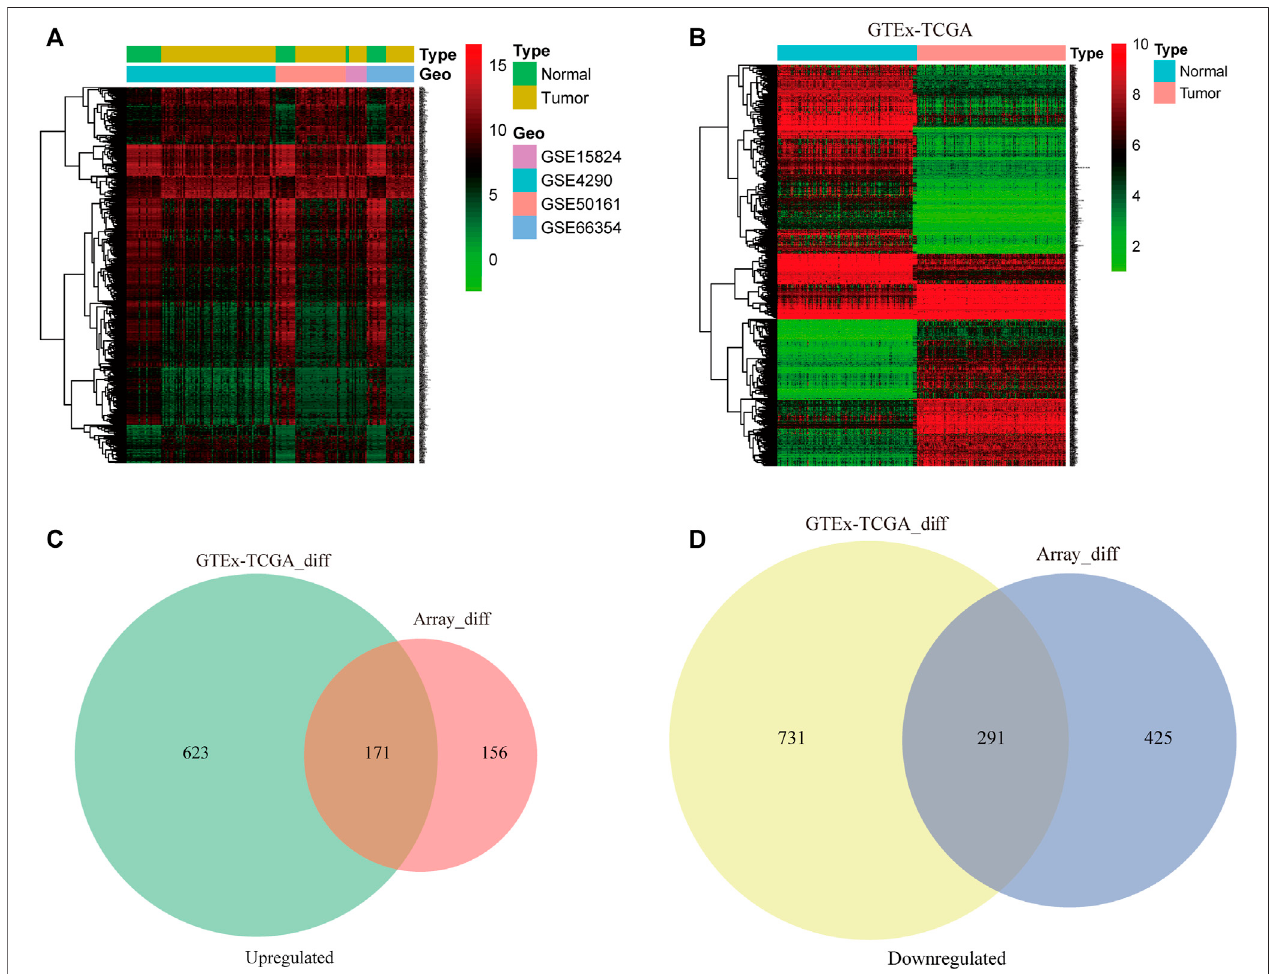
FIGURE2| Thedifferentially expressed genes(DEGs)from multipledatasets areanalyzed.The DEGsinglioblastoma(GBM)andnormalbraintissue samplesfrom the four integrated microarray datasets (A) and Genotype-Tissue Expression (GTEx)-The Cancer Genome Atlas (TCGA) datasets (B) were analyzed by the limma package and are shown in the hierarchical clustering heatmap. Venn diagram analysis of the intersections of the upregulated genes (C) and downregulated genes (D) from four microarray datasets and the GTEx-TCGA datasets.